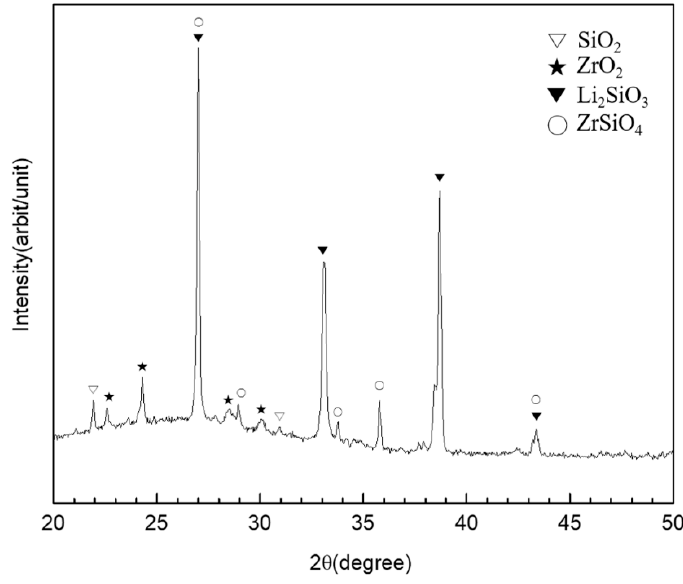
Figure 4. XRD di ff raction analysis of the lithium disilicate-reinforced liner-bonded interface of the zirconia ceramic.